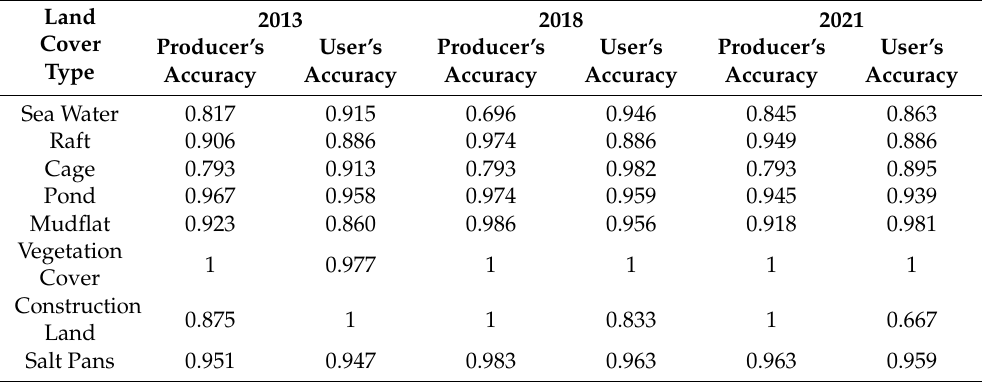
Table A4. User’s accuracy and producer’s accuracy of different land cover type in 2013, 2018, and 2021.